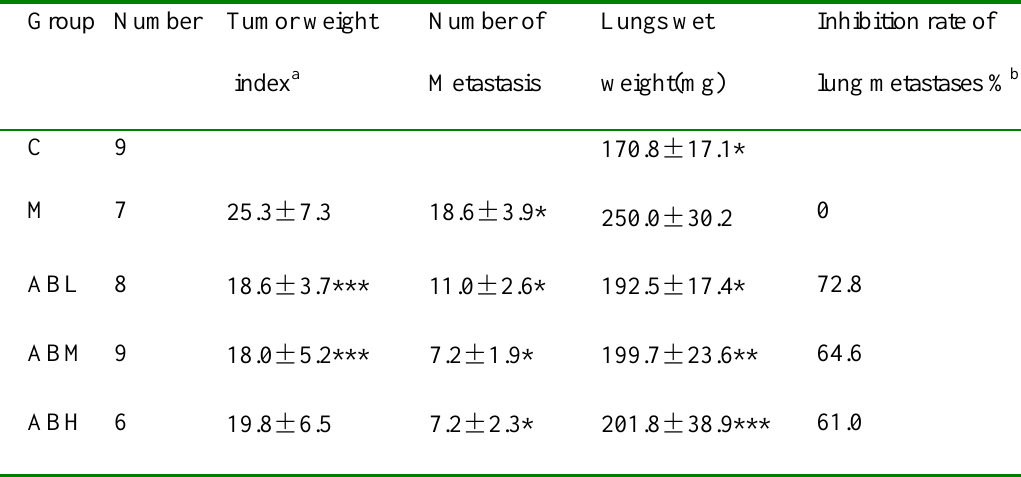
Table 2. Effect of Acetazolamide or combination with NaHCO normal, M: tumor model, B: NaHCO AH: acetazolamide 80 mg/kg, ABL: acetazolamide 20 mg/kg and NaHCO